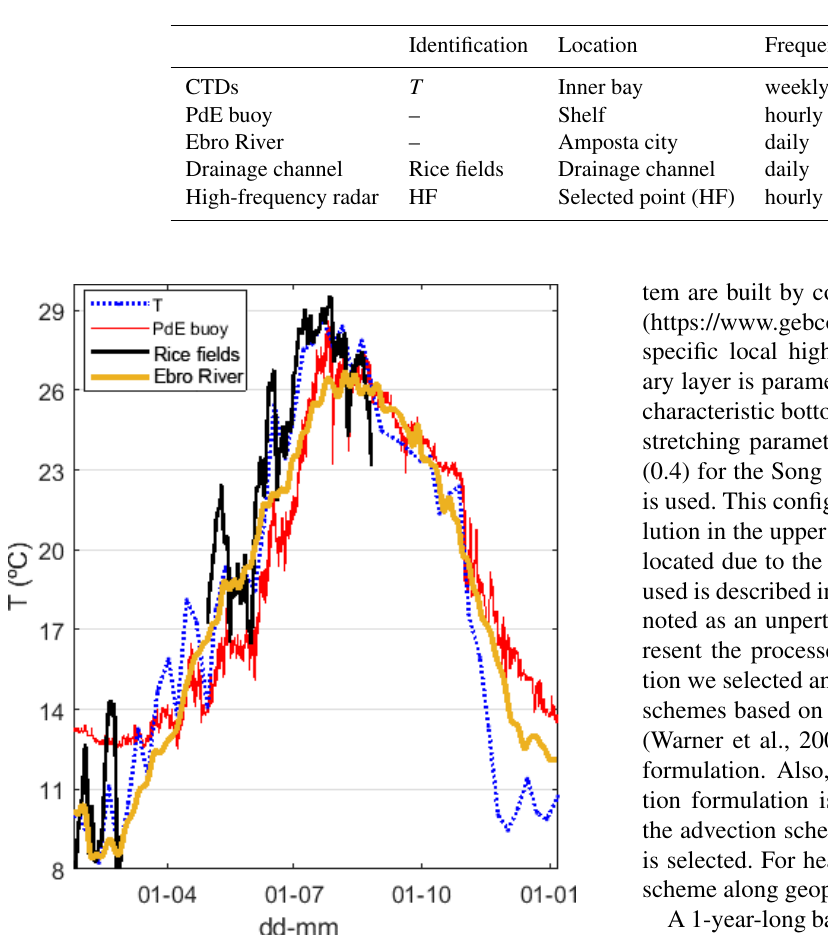
Table 1. Summary of observations (see Fig.1 for identifications).